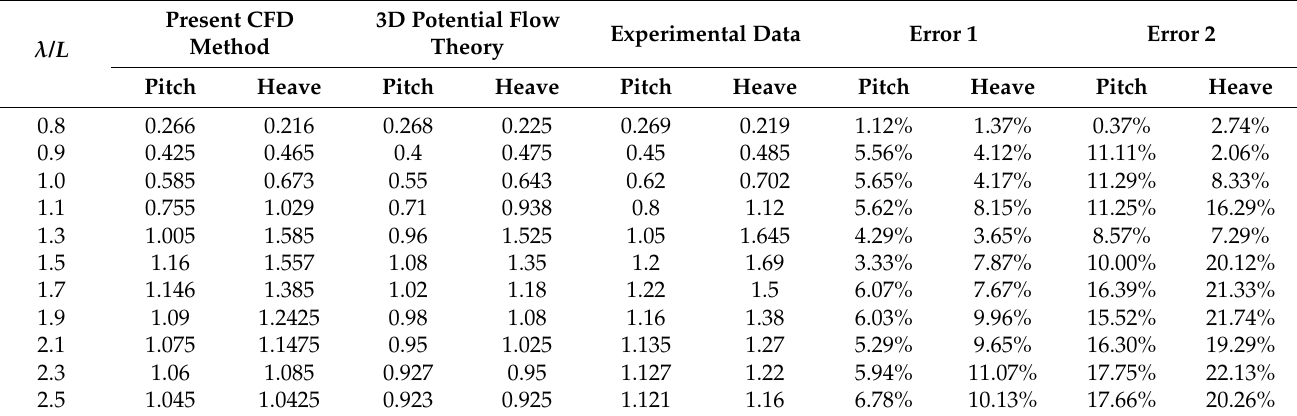
Figure 11. Pitch and heave responses in head wave. ( a ) Pitch; ( b ) Heave. Table 5. Motion error quantification study for head wave case.